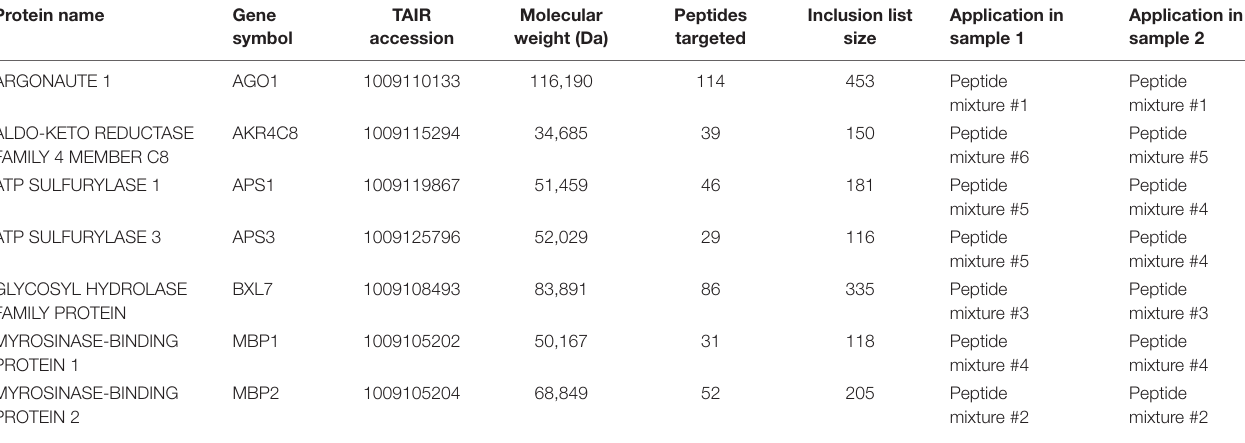
TABLE 1 | miRNA target proteins targeted for relative quantification and details of their associated TDA inclusion